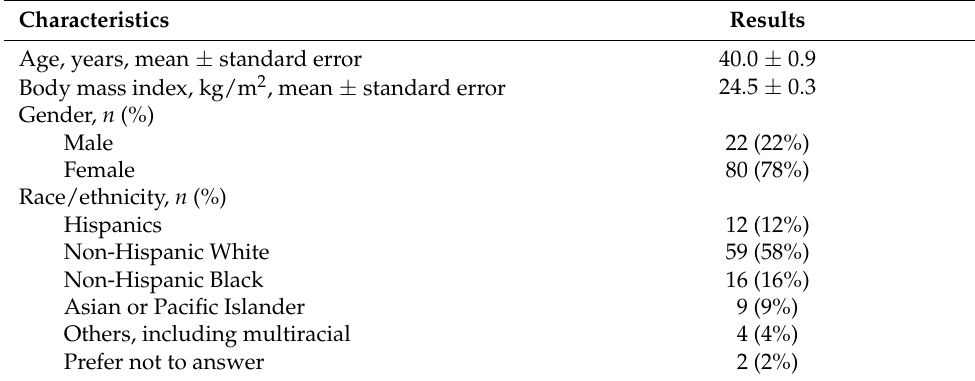
Table 1. Characteristics of